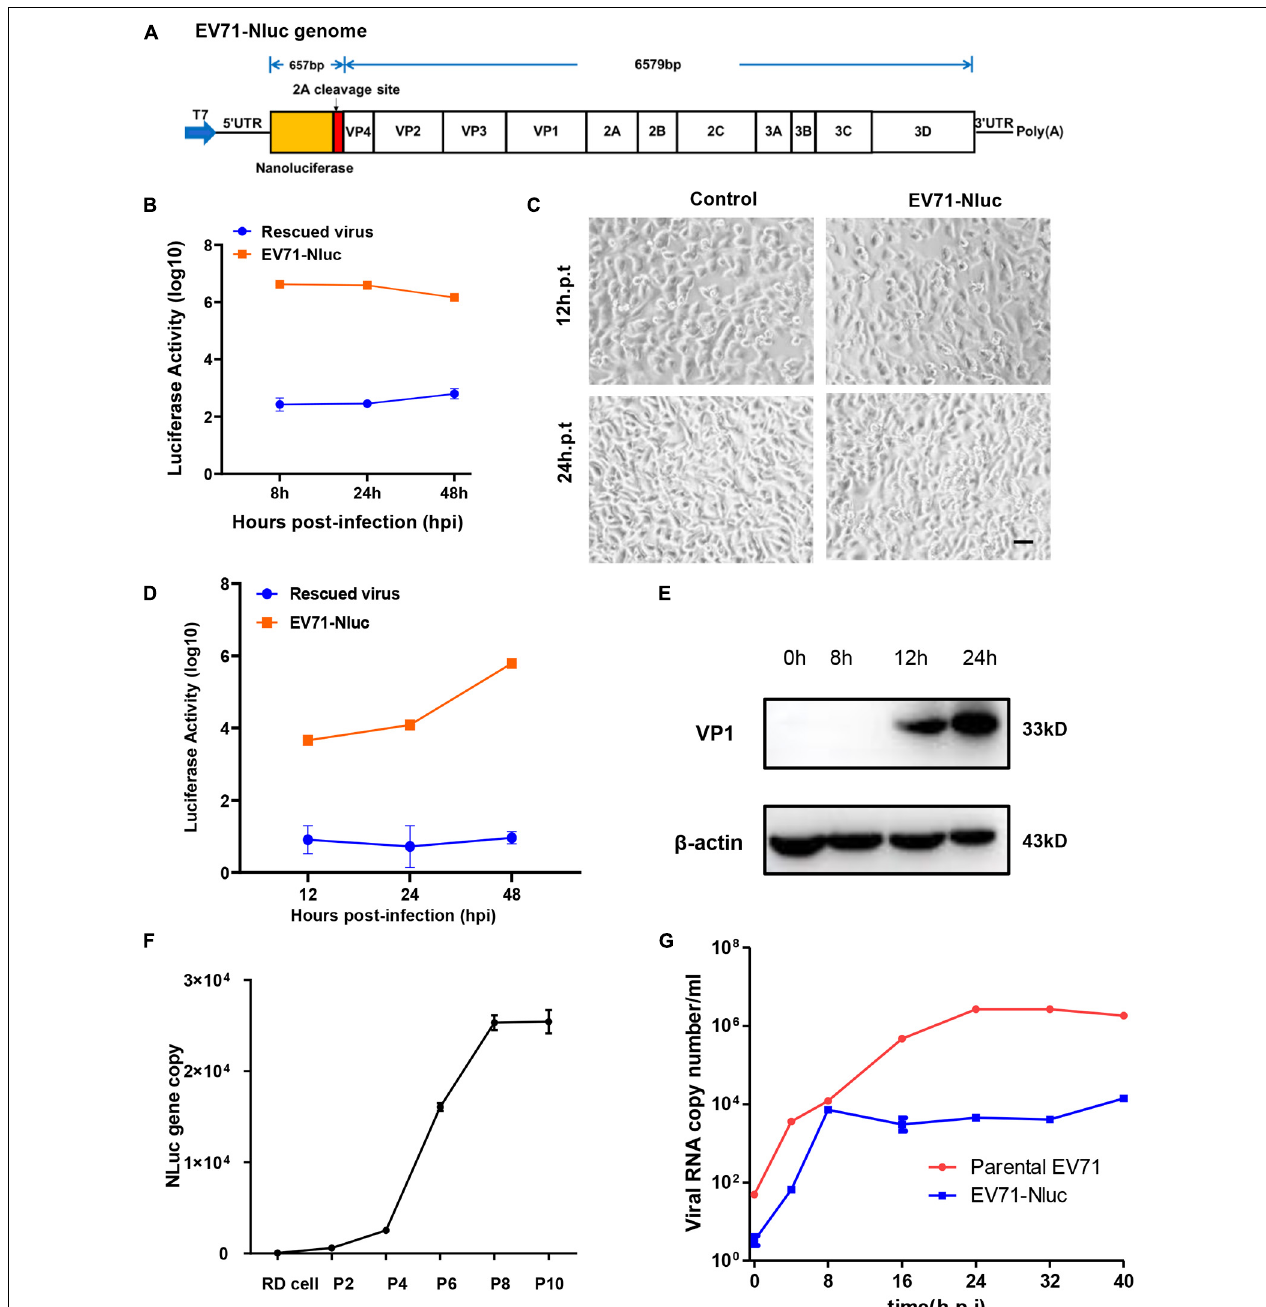
FIGURE 2 | Characterization of full-length EV71 reporter virus. (A) Diagram showing the structure of the full-length EV71 reporter virus. (B) In vitro transcribed viral RNA with or without NanoLuc reporter gene was transfected into RD cells and luminescence was analyzed at different time points. (C) RD cells transfected with vehicle control or full-length EV71 reporter virus RNA were observed at indicated time points for cytopathic effect. Bar, 100 µ m. (D) RD cells infected with EV71 reporter virus were analyzed for luminescence at indicated time points. (E) RD cells infected with EV71 reporter virus were immunoblotted with anti-VP1 antibody. β -actin was used as a loading control. (F) q-RT-PCR analysis of NanoLuc gene in RD cells infected with different passages of reporter virus. (G) Viral RNAs from RD cells infected with parental or reporter EV71 virus were quantitated by q-RT-PCR at various time